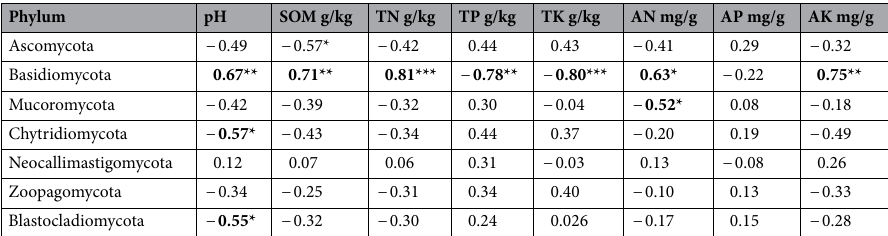
Phylum pH SOM g/kg TN g/kg TP g/kg TK g/kg AN mg/g AP mg/g AK